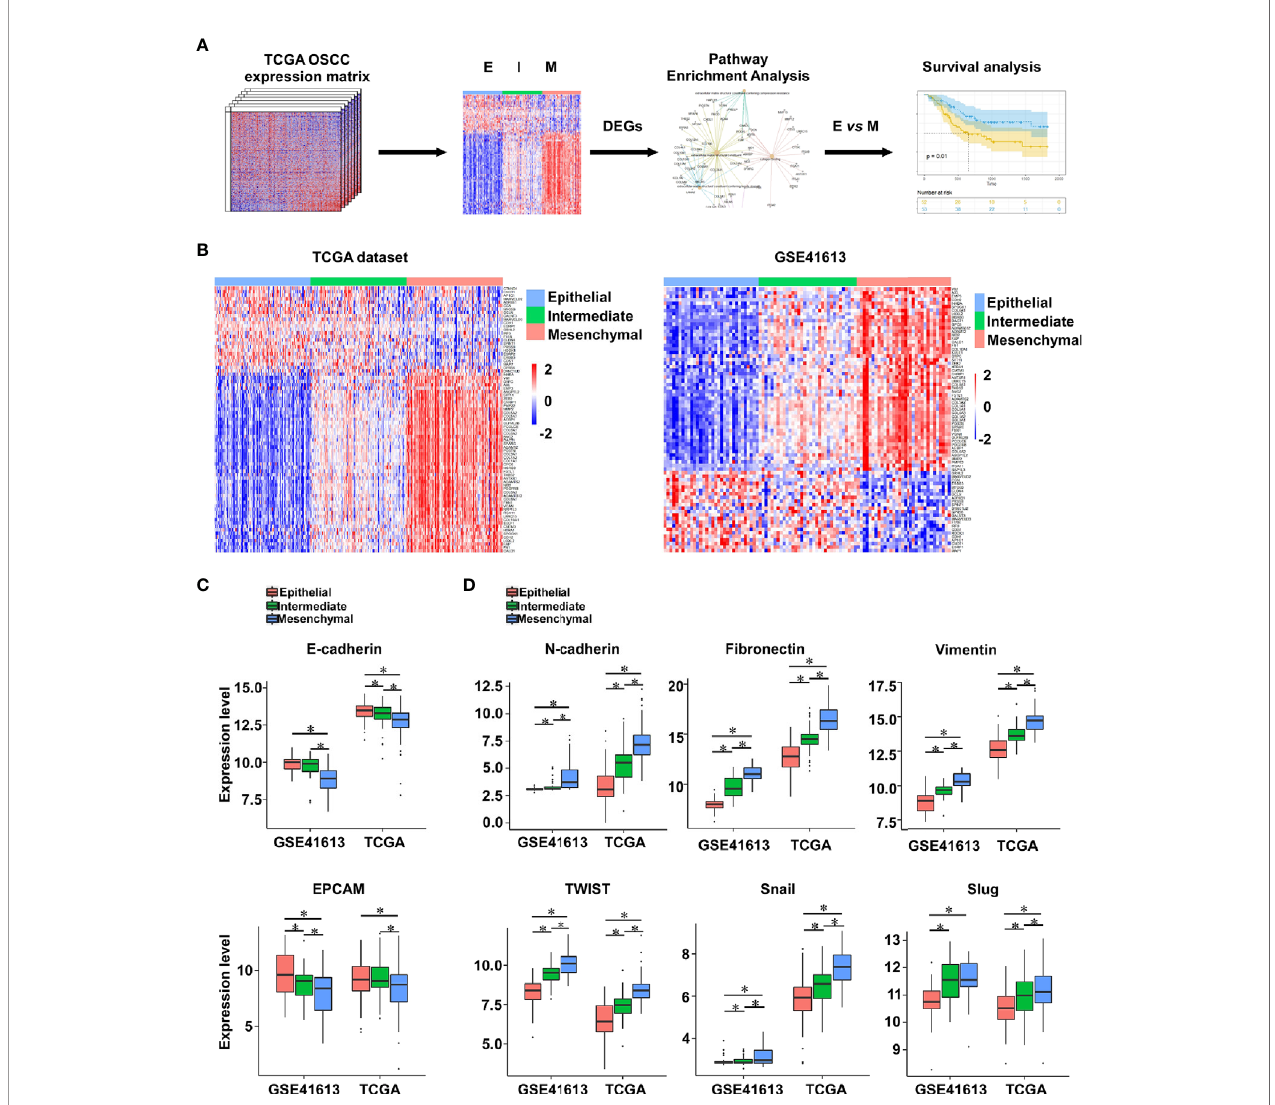
FIGURE 1 | The EMT subtypes are constructed in OSCC. (A) The analytic pipeline in this study. (B) Heatmap of EMT signature gene expression levels in OSCC tumors from the TCGA (n = 315) and GSE41613 (n = 97) datasets. (C, D) The expression levels of epithelial markers (E-cadherin and EPCAM) (C) and mesenchymal markers (N-cadherin, fi bronectin, vimentin, SNAIL, SLUG, and TWIST) (D) in OSCC tumors. * p value < 0.05, mean ± s.d., student ’ s t